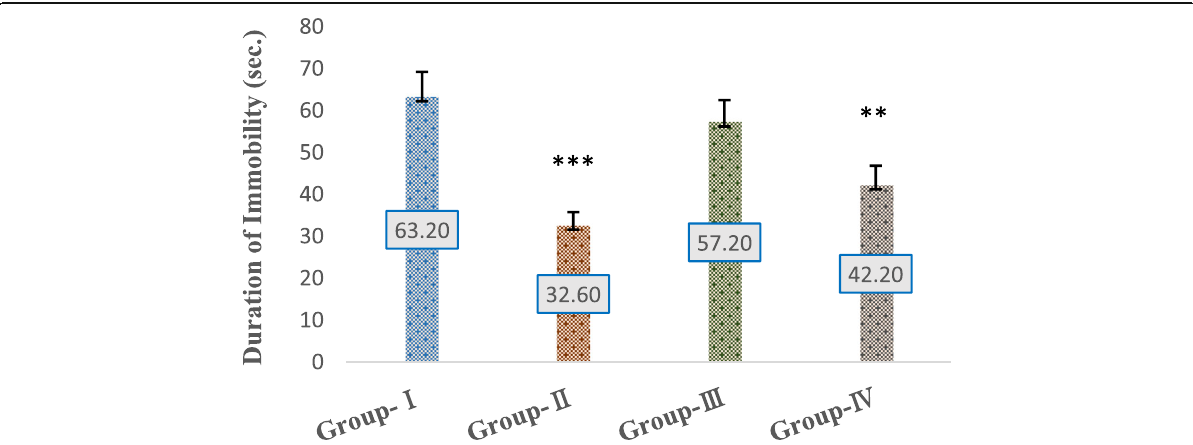
Fig. 6 Effect of Psidium guajava Linn leaves extract on the duration of immobility in forced swimming test. Group I = control group, group II = positive control group, group III = Psidium guajava Linn low strength group, group IV = Psidium guajava Linn high strength group. ** p < 0.01, *** p < 0.001 vs group I